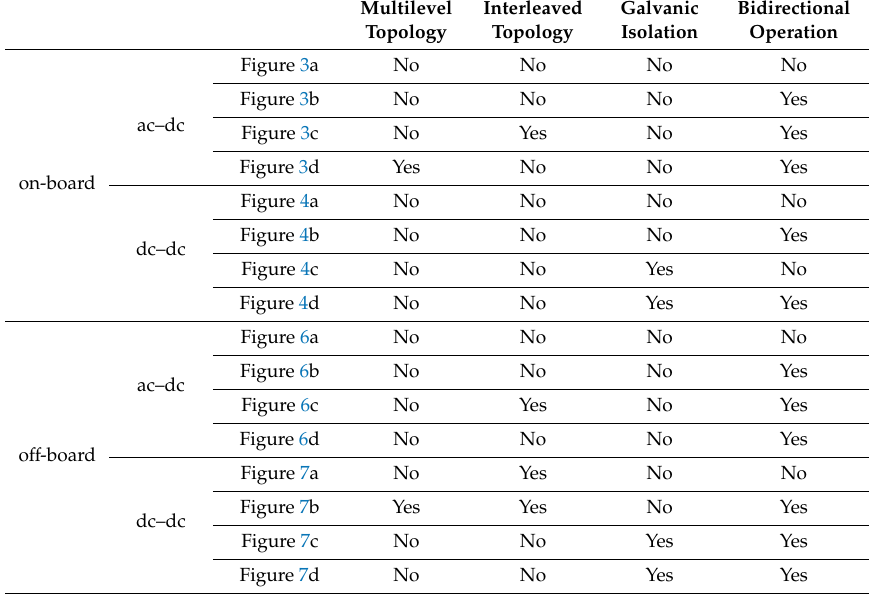
Table 3. Comparison of the main features of the power electronics converters for on-board and o ff -board EV battery charging systems